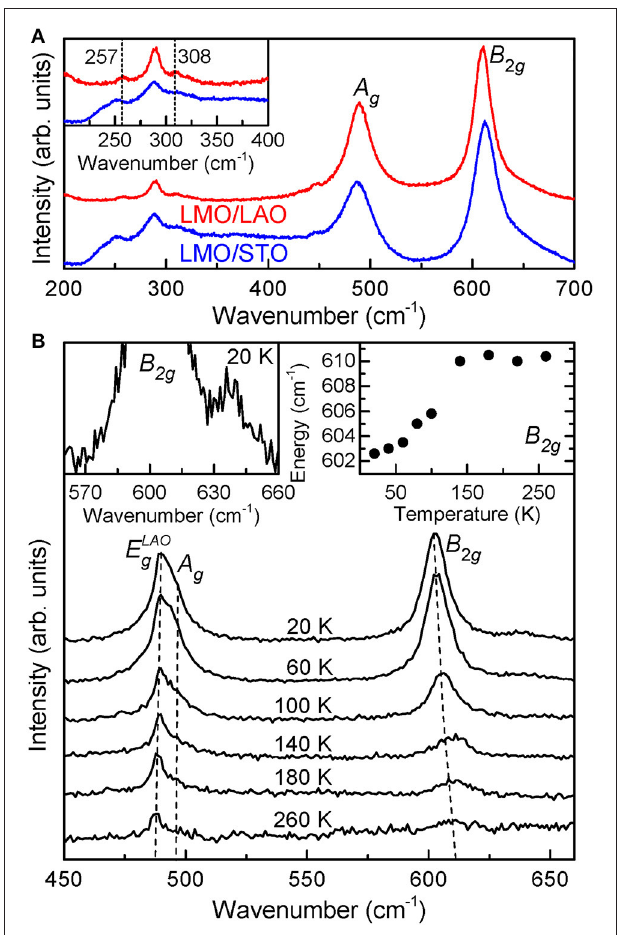
FIGURE 5 | (A) Raman shift at room temperature from corresponding samples of LMO samples grown on STO (blue) and LAO (red) substrates. (B) Raman spectra of LMO/LAO sample at low temperatures. Right inset: Temperature dependence of B 2g wavenumber. Left inset: Enlarged part of Raman spectrum measured at